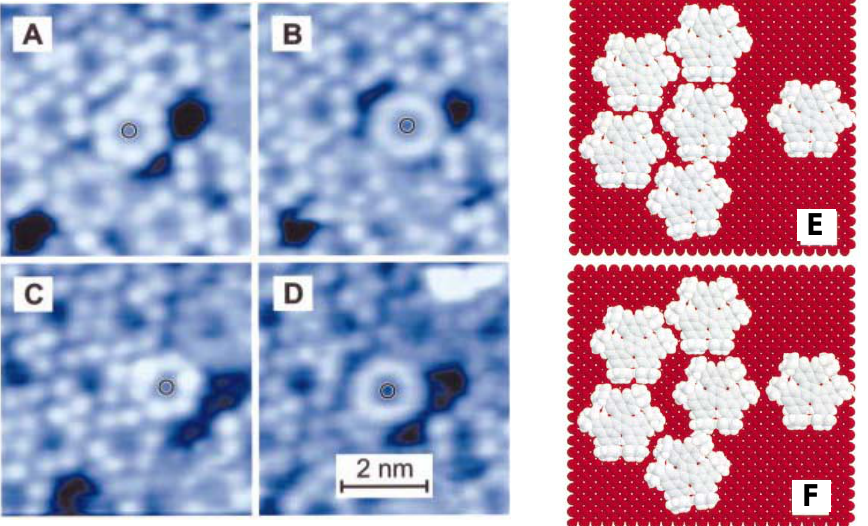
Figure 13. UHV-STM images (A-D) and tentative models (E and F) of propeller-shaped hexa- tert -butyl decacyclene on Cu(100) at room temperature. Reproduced from reference [63] by permission of the American Association for the Advancement of Science.